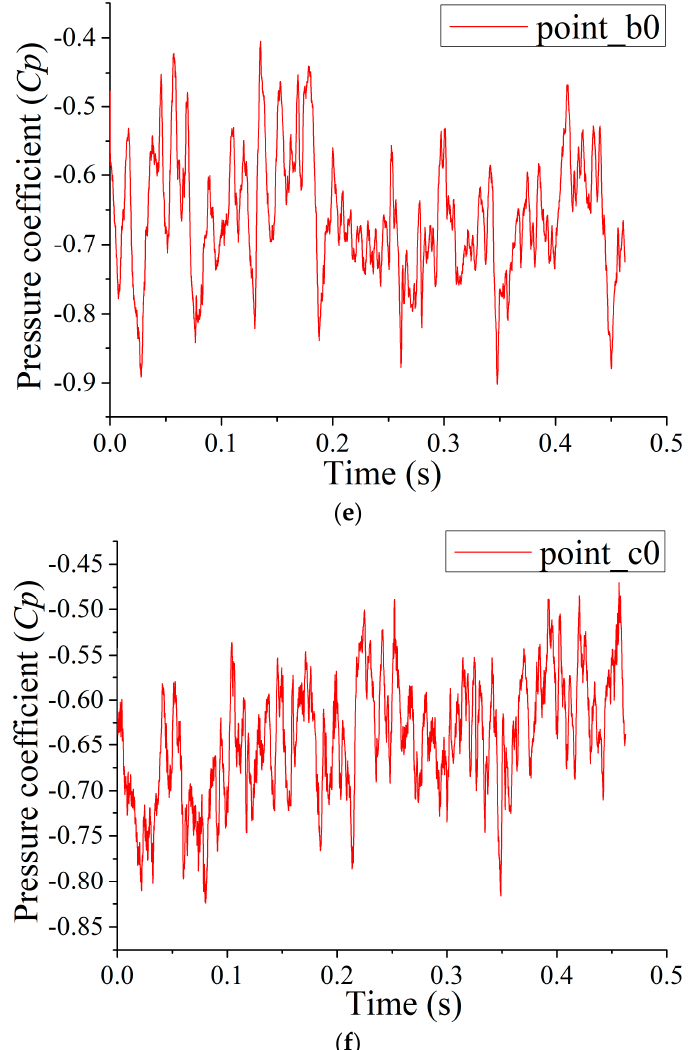
Figure 24. Pressure coe ffi cient at monitoring points under a flow rate of Q / Qn = 0.031. ( a ) at point a, ( b ) at point b, ( c ) at point c, ( d ) at point d, ( e ) at point b0, ( f ) at point c0,